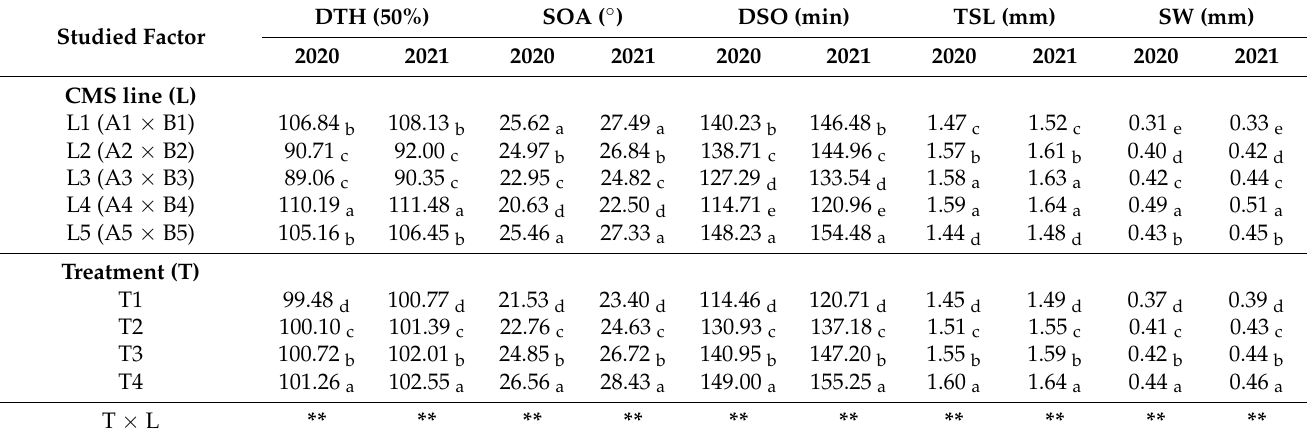
Table 3. The impact of two isolated cyanobacteria and their mixture on days to heading (DTH), spikelet opening angle (SOA), duration of spikelet opening (DSO), total stigma length (TSL), and stigma width (SW) of CMS lines. The table represents the mean performance of CMS lines under all treatments (upper part) and the mean performance of treatments in all CMS lines (down part) with regard to measured floral